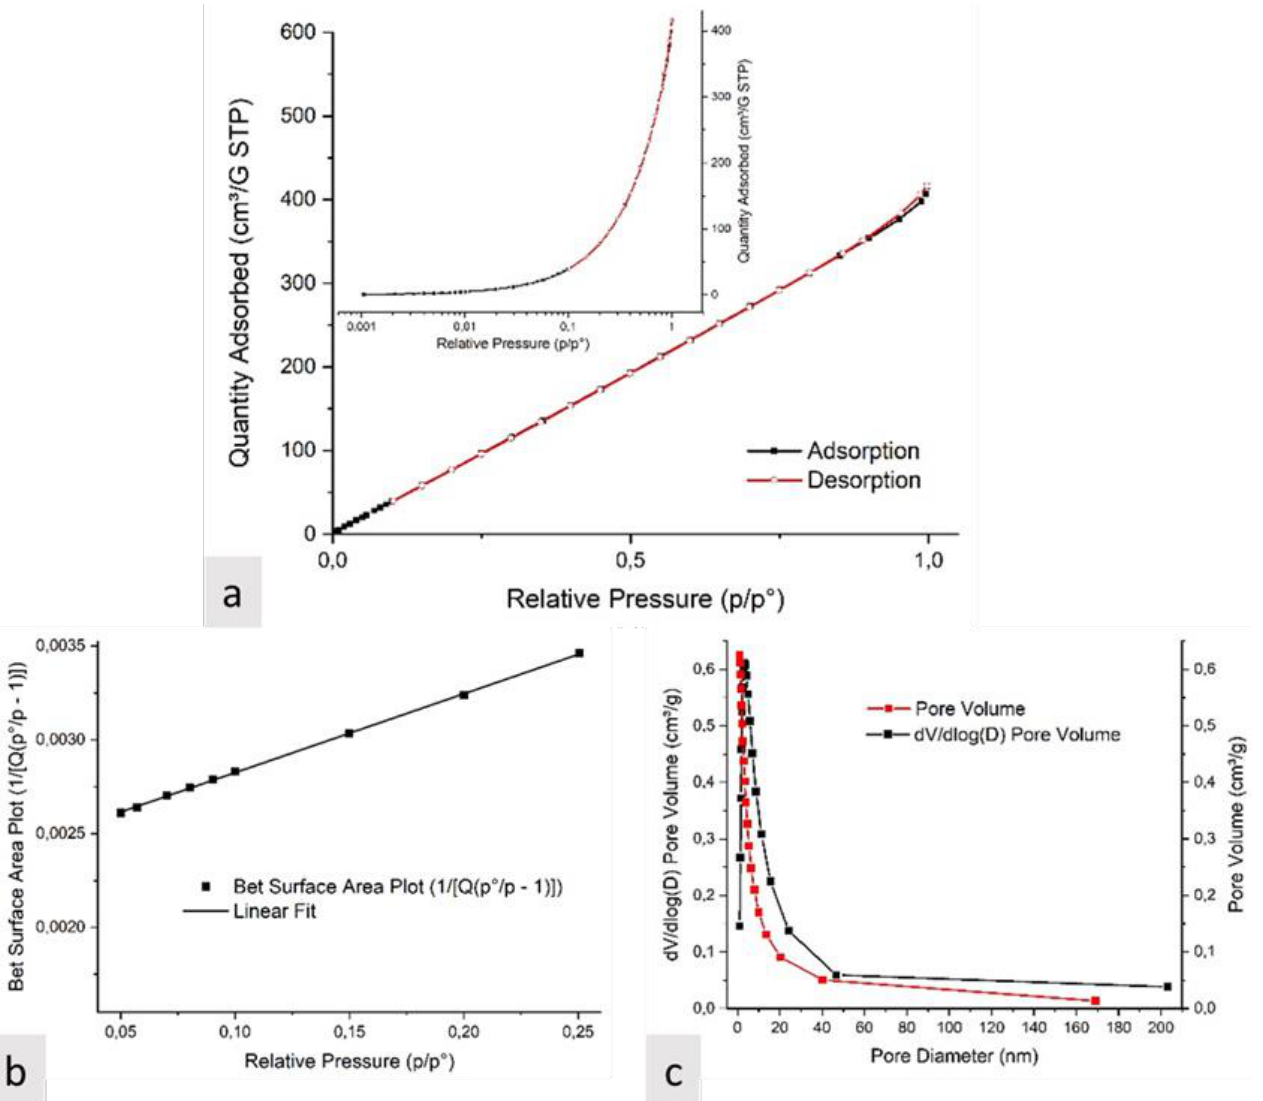
Figure 8. ( a ) Isotherms of nitrogen adsorption at 77 K (logarithmic plot in the inset); ( b ) BET surface area plot; ( c ) pore size distribution (BJH model).